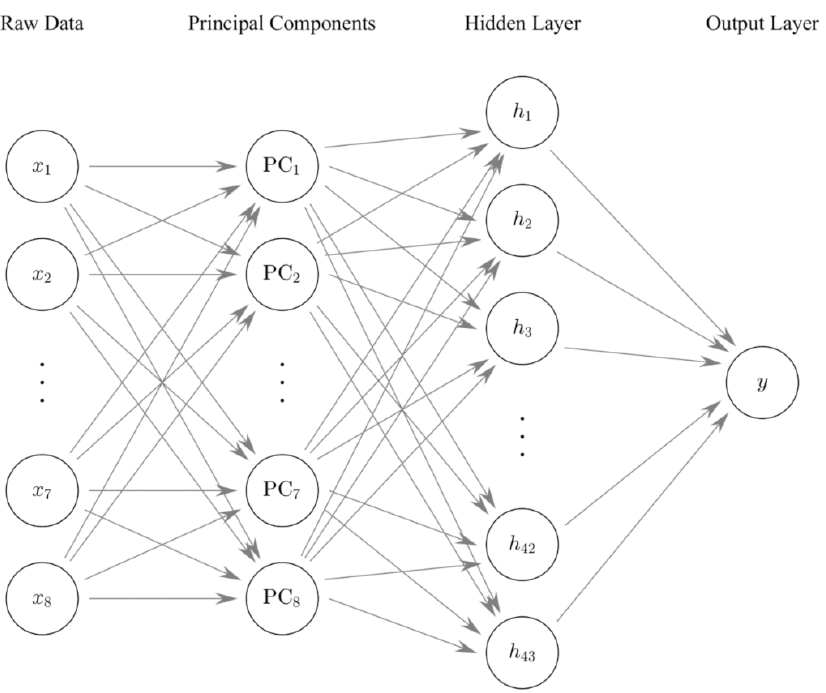
Figure 2. Schematic diagram of FFBP ANN.